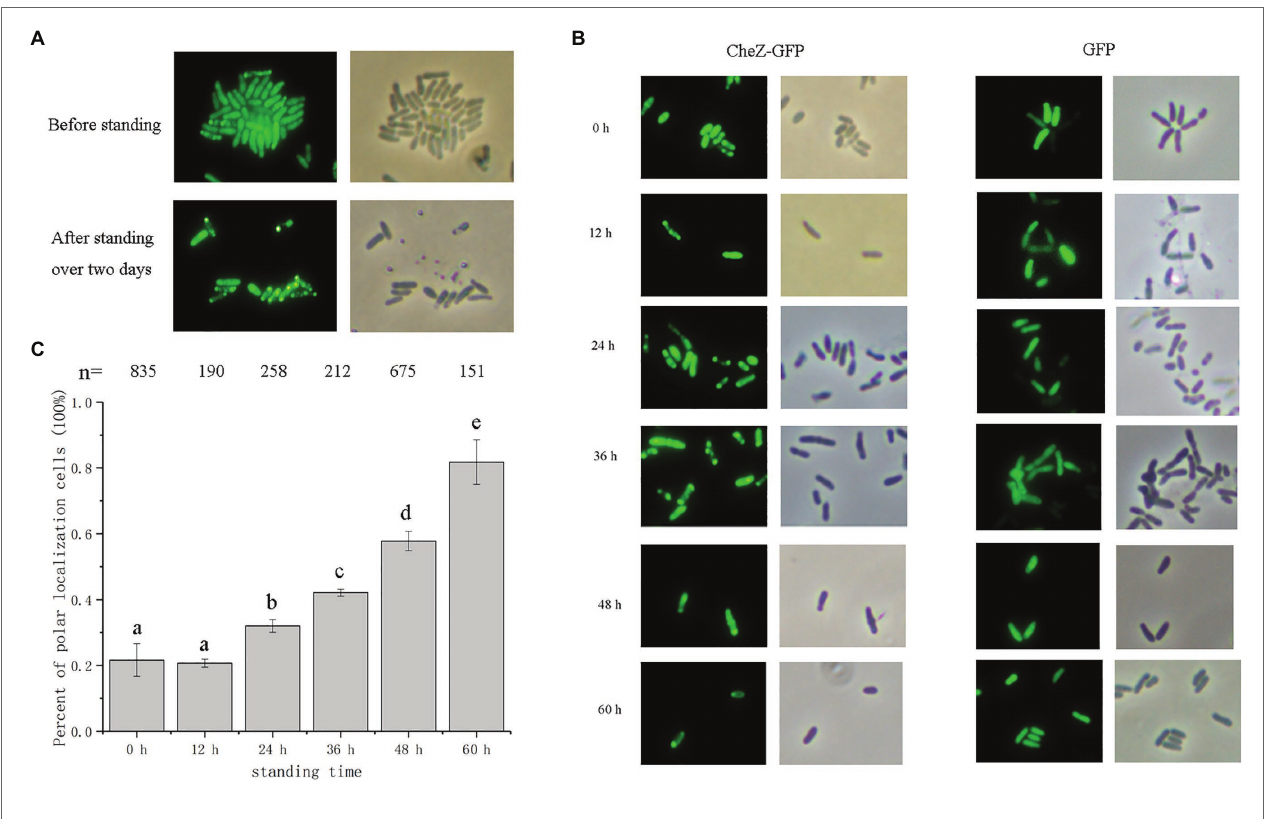
FIGURE 1 | Localization of CheZ-GFP with cell standing time. (A) Representative images of overnight culturing Azospirillum caulinodans cells with CheZ-GFP before standing or after standing over 2 days. (B) Representative images of cells with CheZ-GFP or GFP-only with standing time from 0 to 60 h. (C) Quantification of